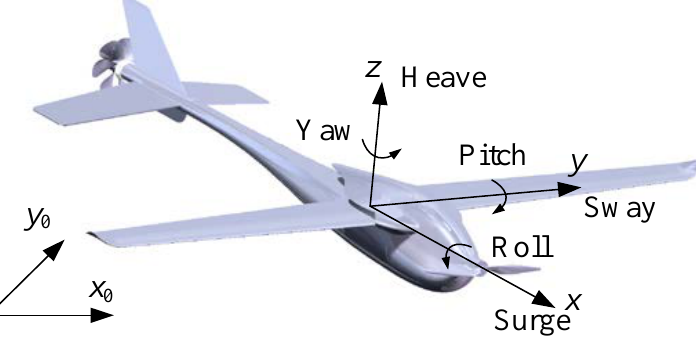
Figure 4. Schematic diagram of the Earth-fixed coordinate and body-fixed coordinate system of the UAUV.